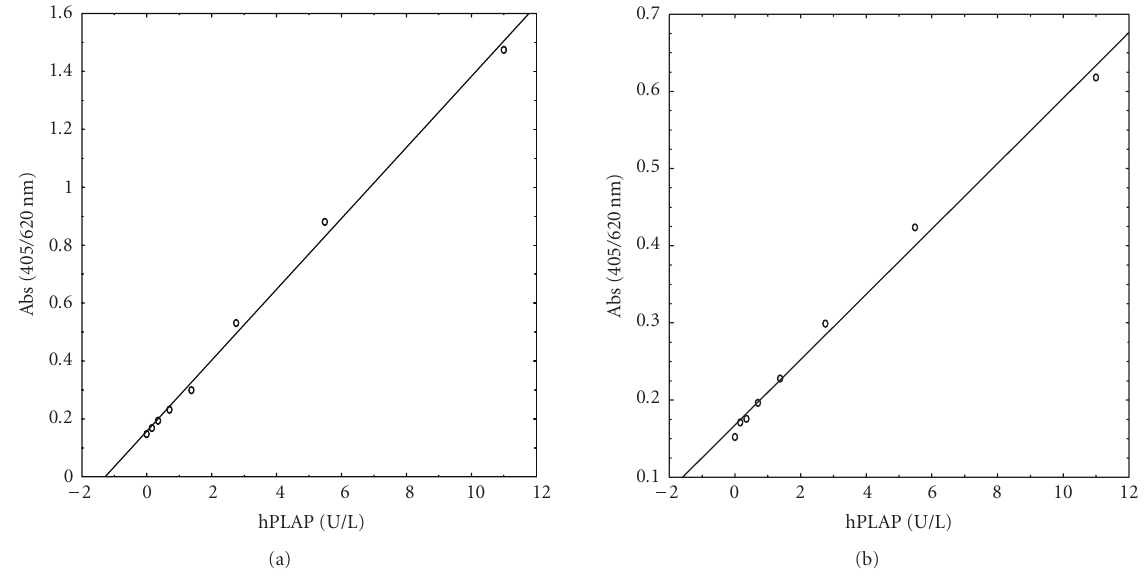
Figure 1: Representative standard curve for the (a) ICA-PLAP and (b) ICA-PEP